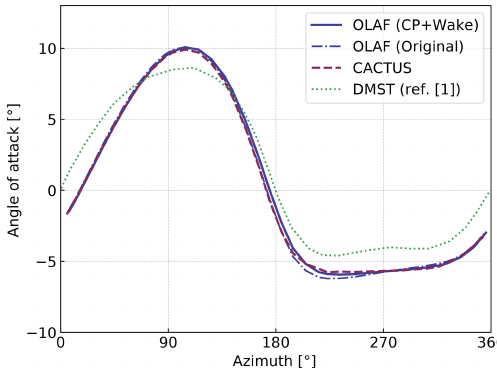
Figure 7. Angle of attack on a 2D VAWT as obtained with various vortex methods and with the double-multiple streamtube (DMST) theory.